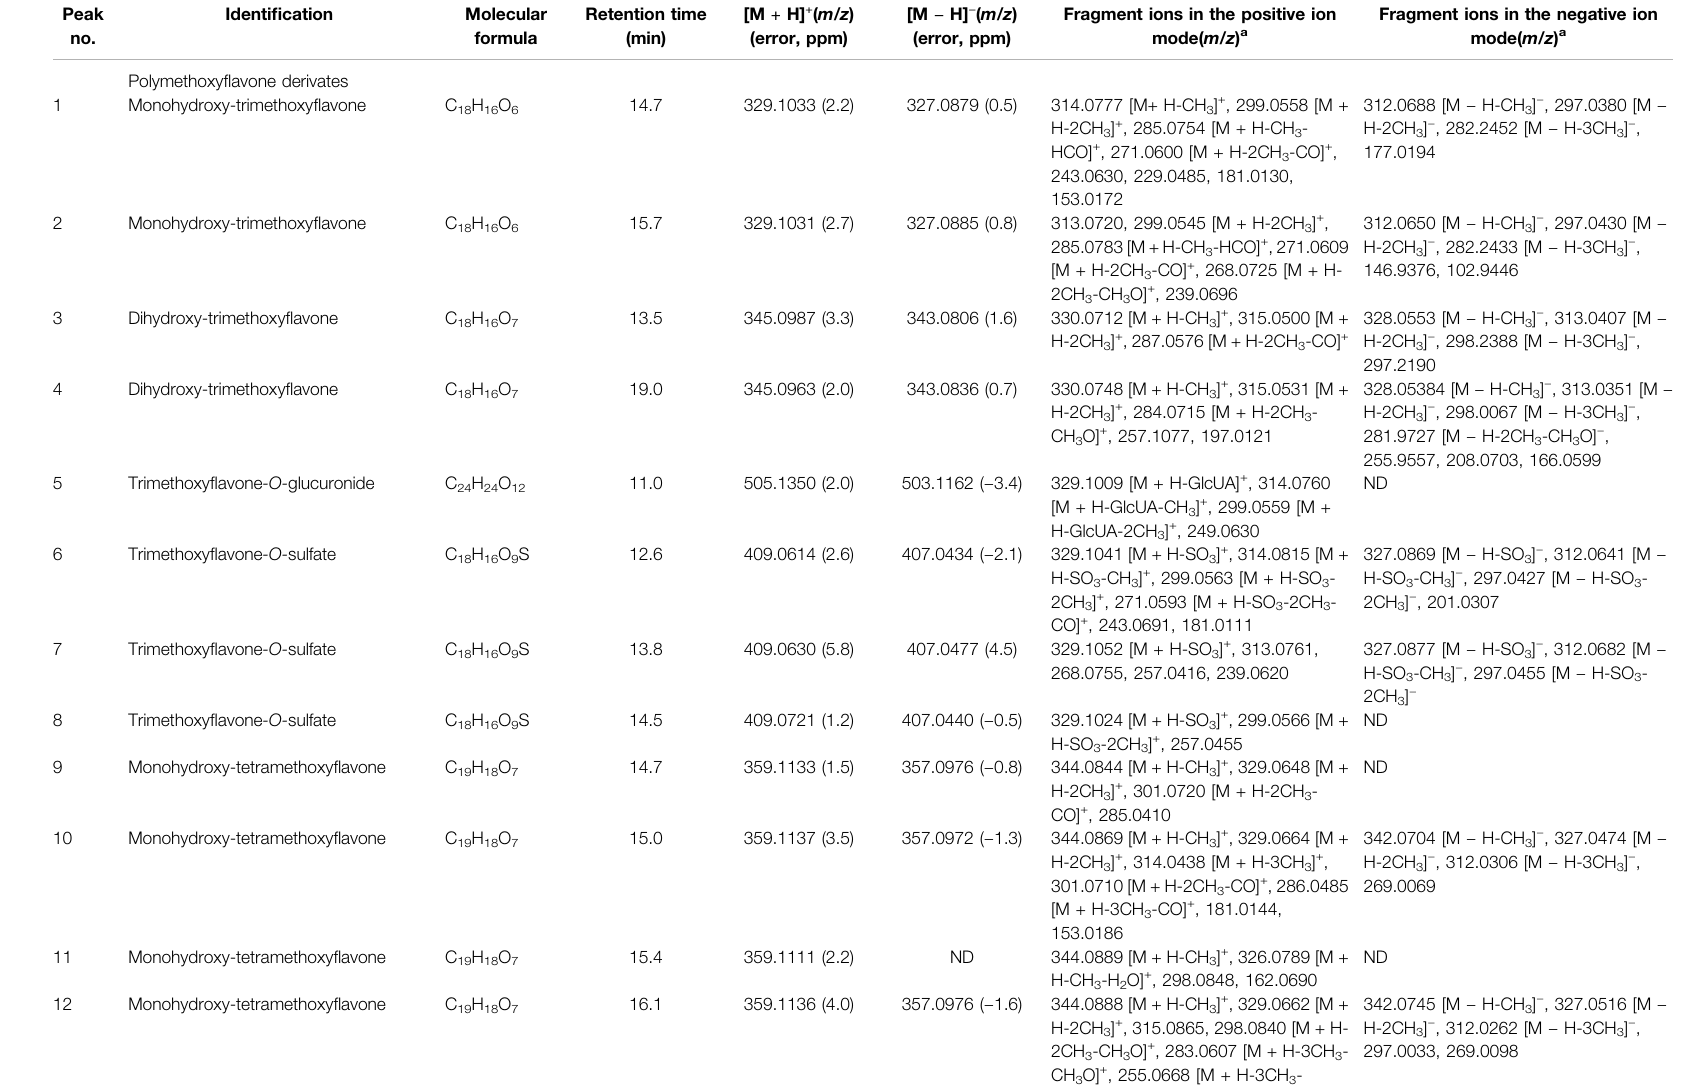
TABLE 2 | Identi fi cation of metabolites in rat urine, and feces samples after the oral administration of Citri Reticulatae Pericarpium extract. Peak